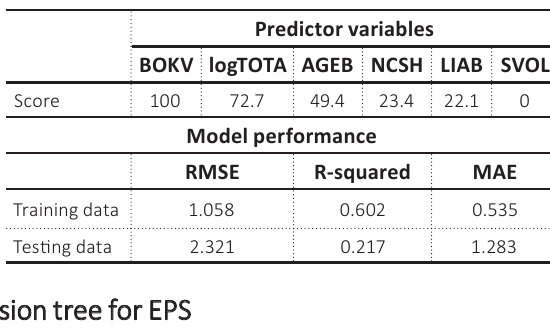
Table 5. Pruned regression tree variable importance scores and performance metric for EPS